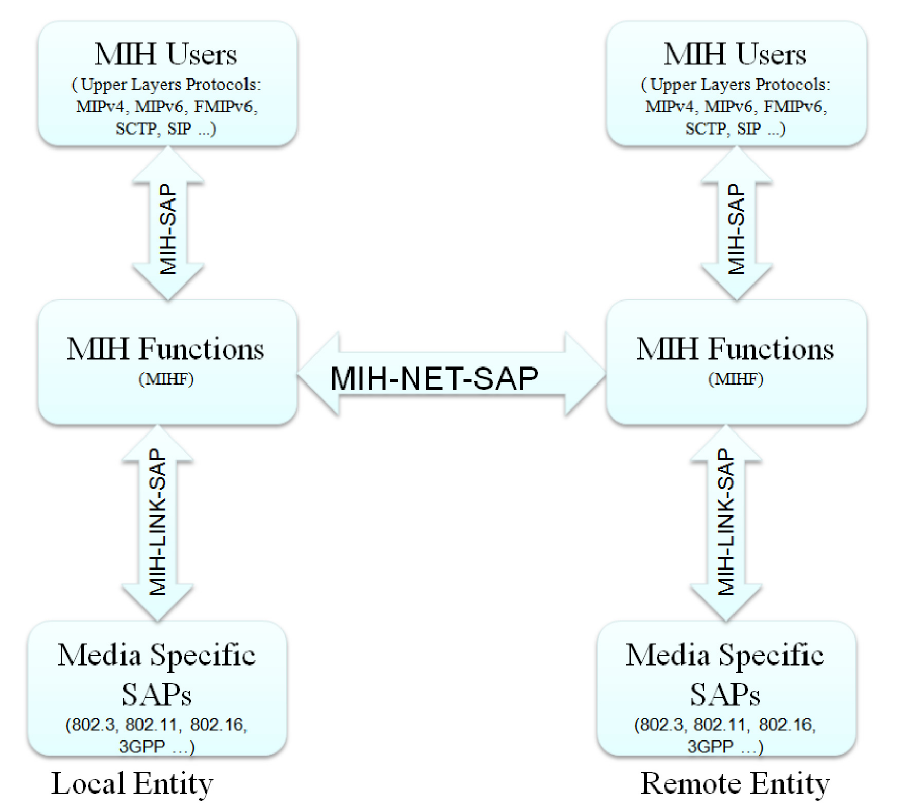
Fig 1. High level media independent handover